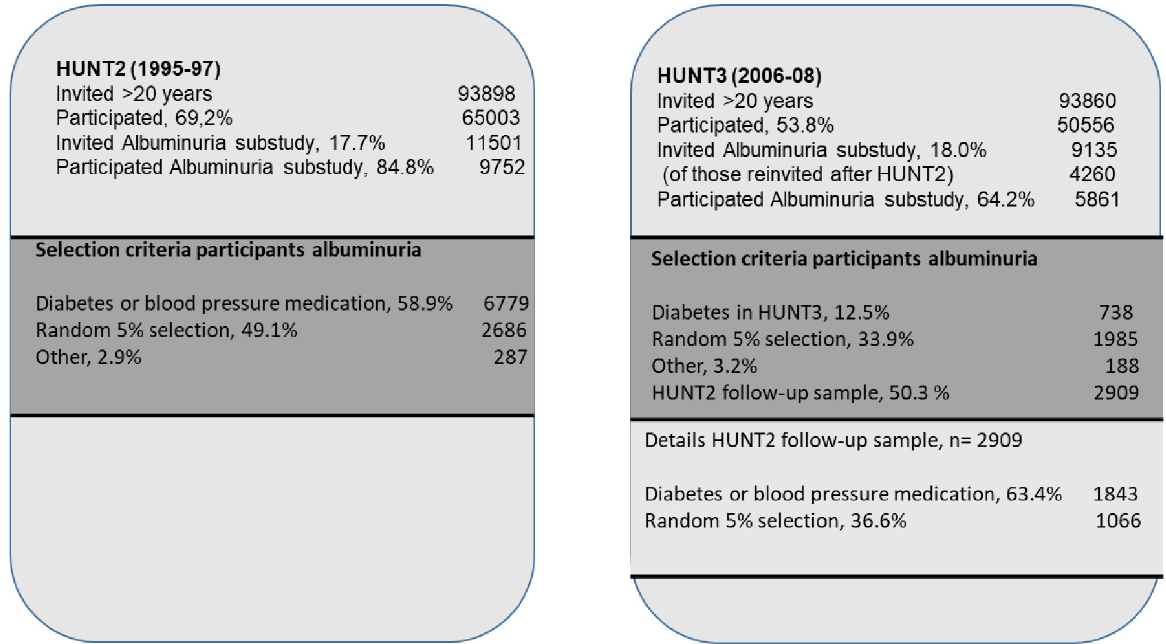
Fig 1. Flow chart of recruitment of the participants in the